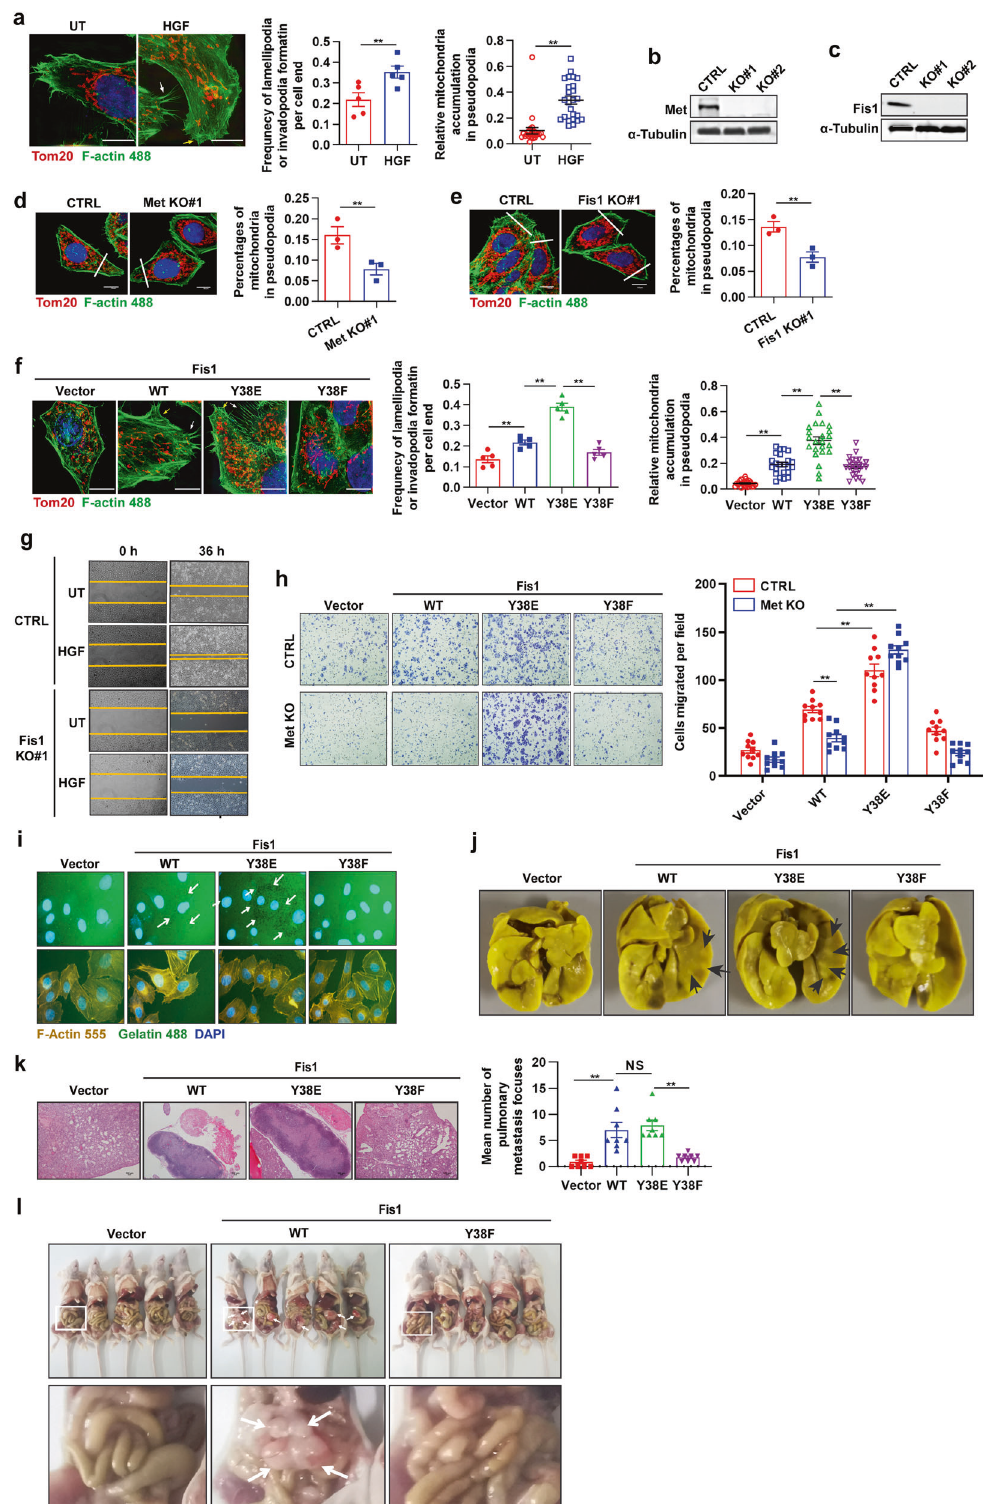
Our study further improved the downstream regulation network of Met in tumor metastasis. As wound healing assay showed, HGF induced enhanced cell migration was almost blocked by Fis1 knockout (Fig. 6g), and in a nude mice pulmonary metastasis model, Met mediated Fis1 pY38 was necessary for metastatic